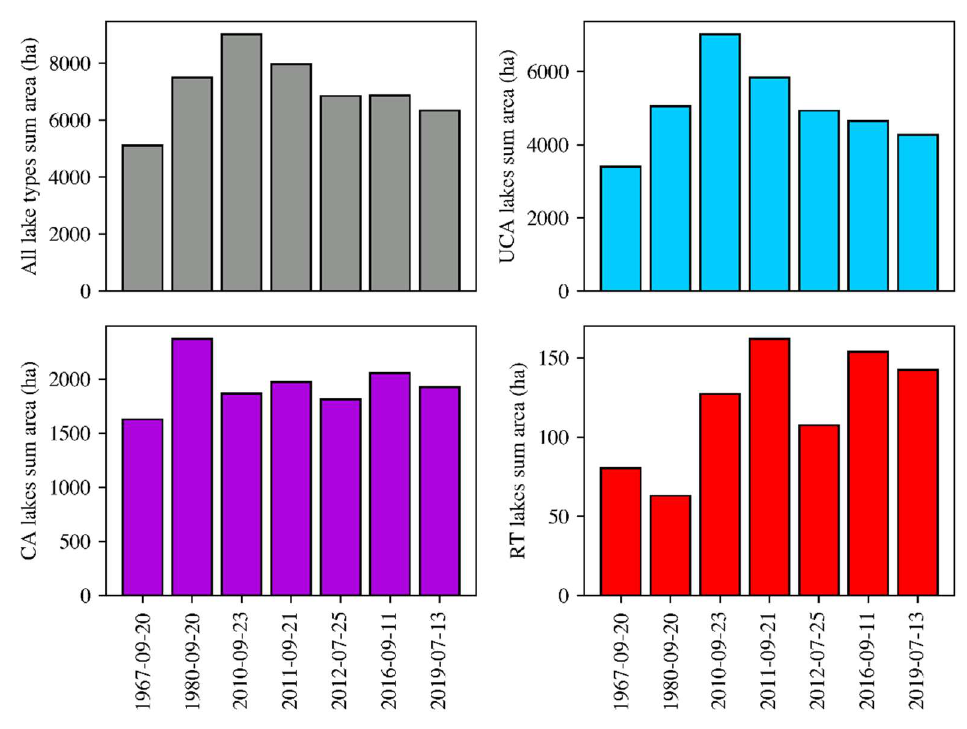
Figure 15. Histograms of lake surface area for the center study site for all lake types (gray), UCA lakes (blue), CA lakes (magenta), and RT lakes (red).